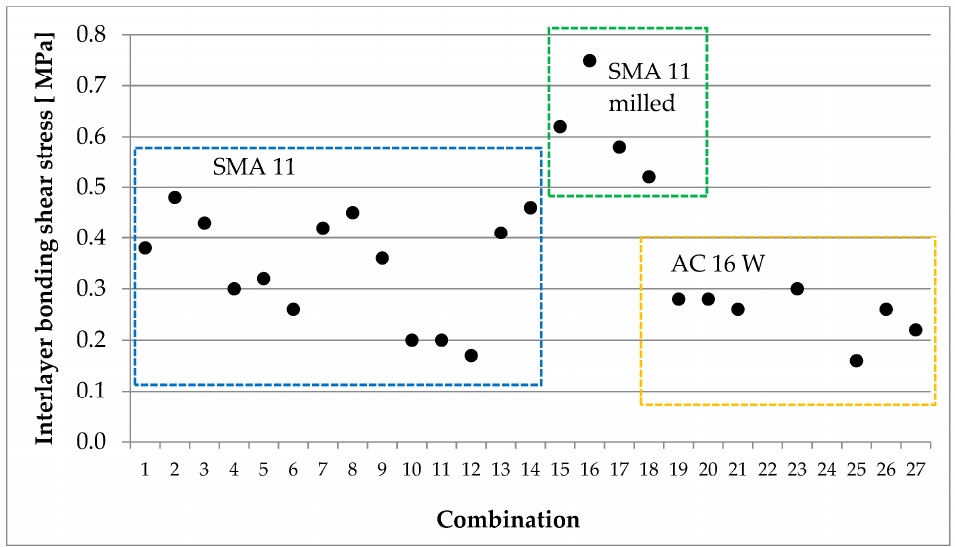
Figure 6. Interlayer bonding test result–shear stress.